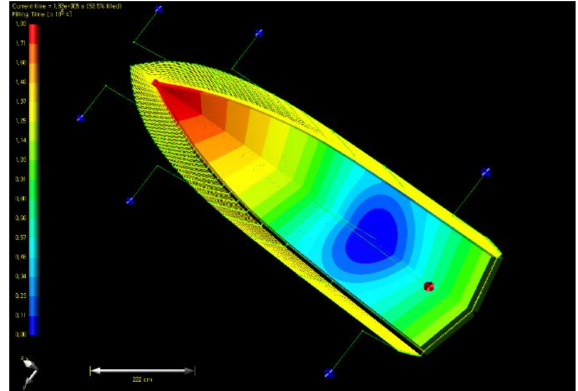
Figure 10. Resin flow analysis result of case 1 (filling time).